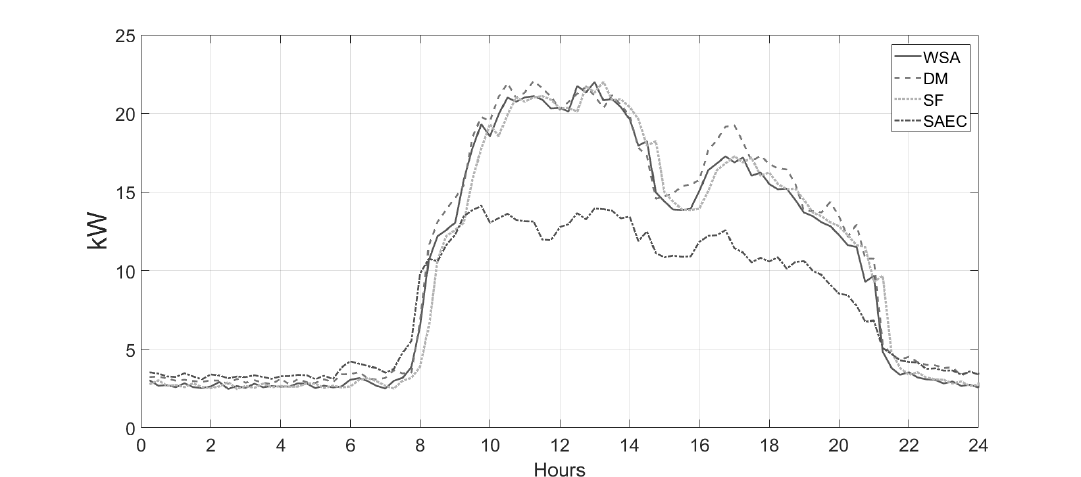
Figure 9. Standard deviation of the consumption